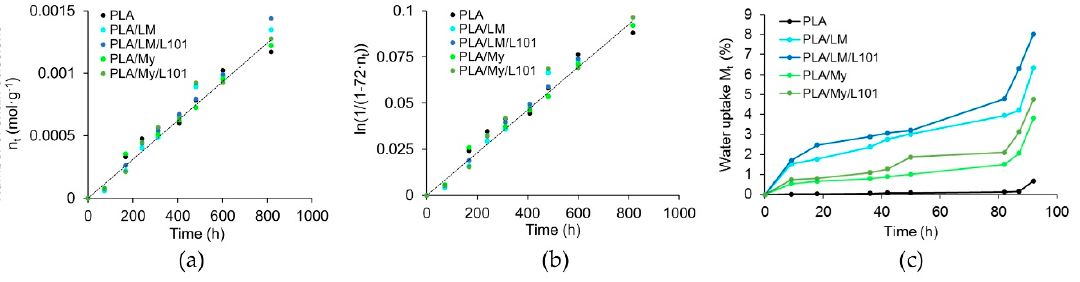
Figure 10. Characterization of polylactide (PLA)-based materials hydrothermal ageing in water at 70 ◦ C. ( a ) Evolution of PLA number of chain scissions n t as a function of time, ( b ) hydrolysis kinetic linear regression and ( c ) evolution of the sample water uptake M t as a function of time determined by weighing.